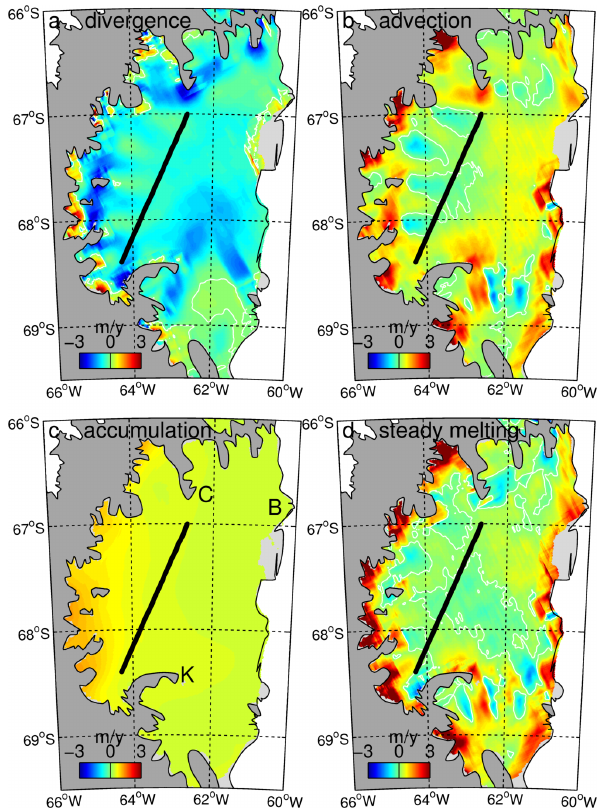
Figure 8. Fields of derived values for the terms in the ice-only mass (cid:113) u ); balance (positive implies melting): (a) ice divergence ( − I ∇ (cid:113) ∇ I ); (c) ice surface accumulation; (d) de- (b) ice advection ( − u rived steady-state basal melting. (c) shows geographical features re- ferred to in the text: B is Bawden Ice Rise; C is Churchill Peninsula; K is Kenyon